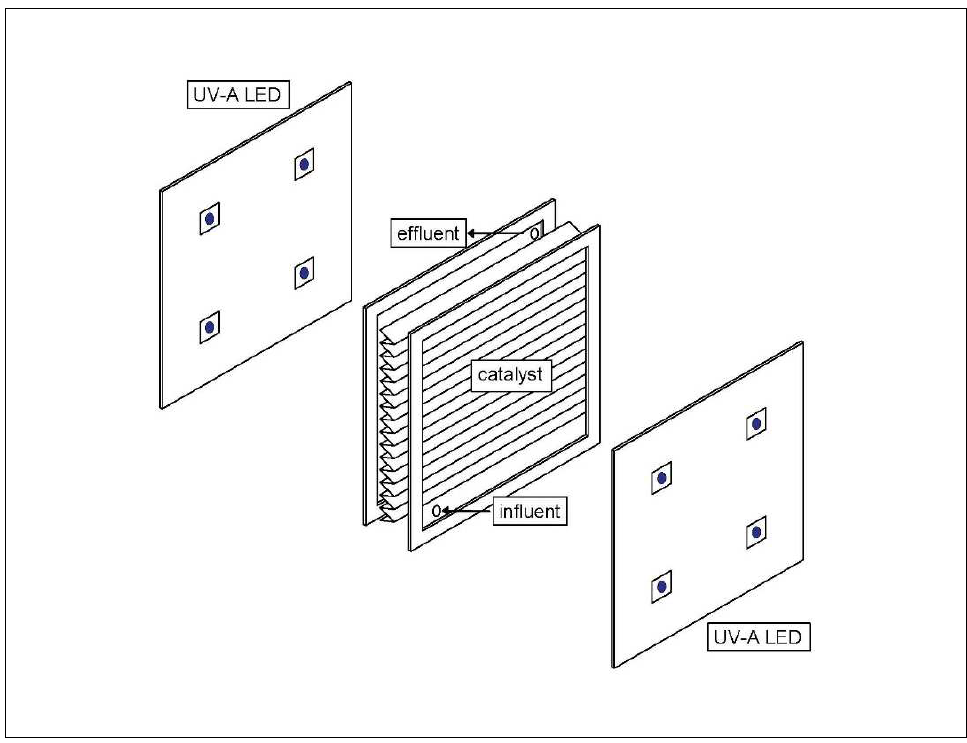
Figure 2. Schematic 3D-Model of the photocatalytic flat cell reactor.